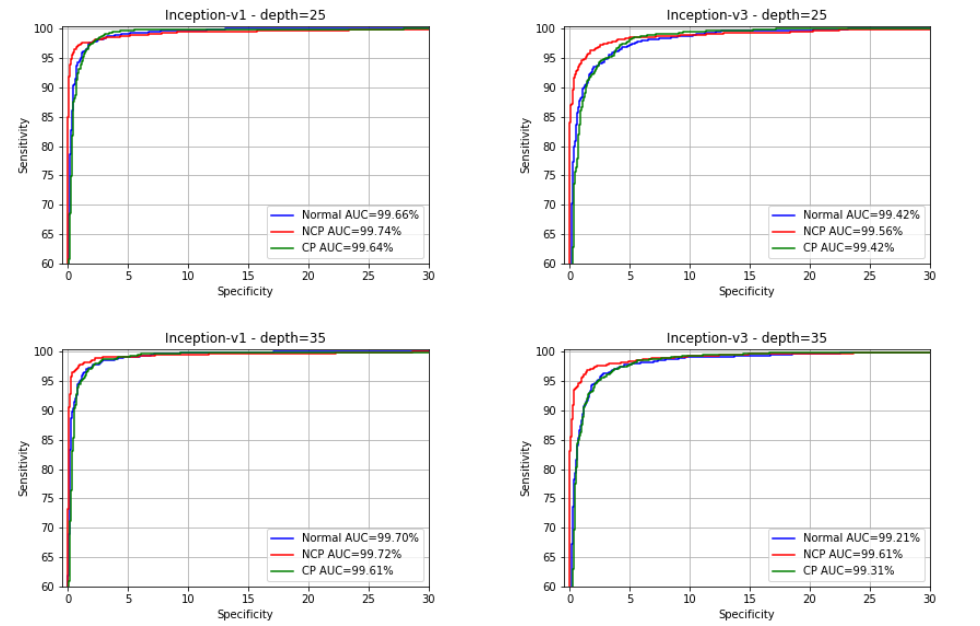
Figure 14. ROC curves for ensemble models built using the soft-voting